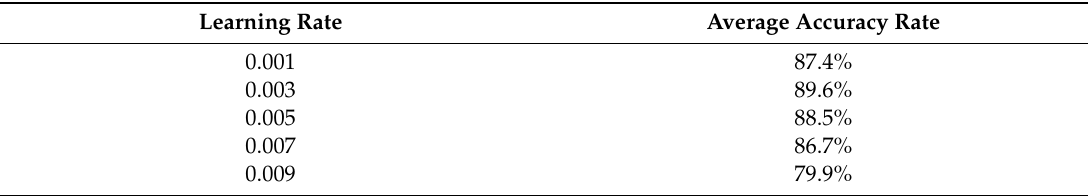
Table 2. Comparison of accuracy with di ff erent learning rates.